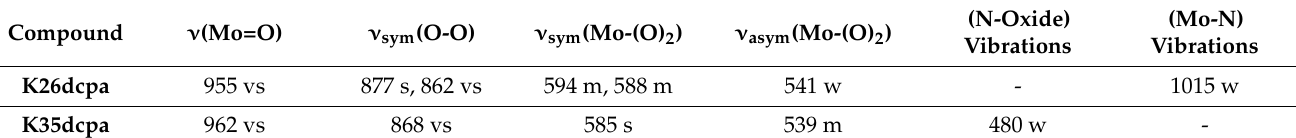
Table 3. IR spectra vibrations and band assignments of investigated oxodiperoxidomolybdates (based